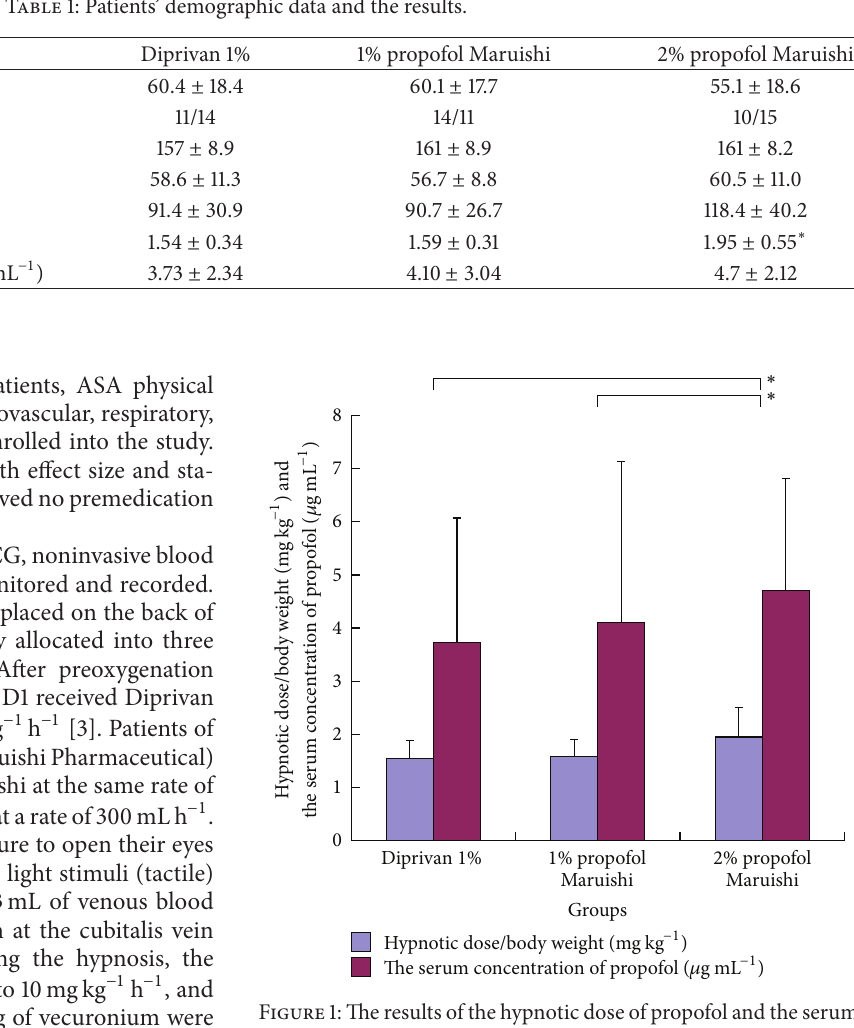
Table 1, Figure 1). Age ( −0.66 ± 0.19 mg a year (regression coefficient and SE), 𝑝 < 0.002 ) and gender ( −28.6 ± 6.9 mg, 𝑝 <